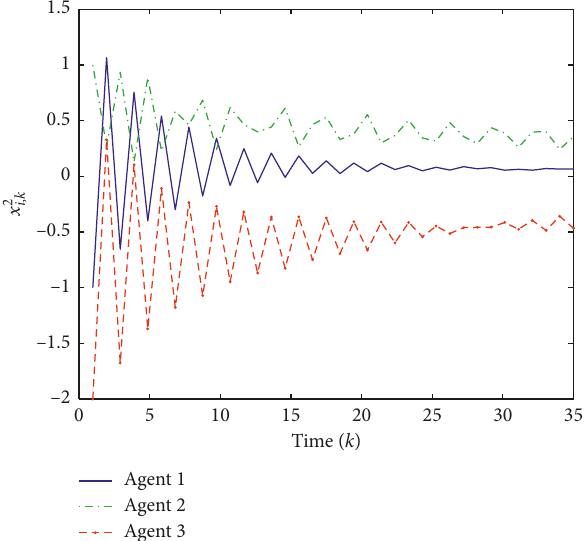
Figure 2: The state trajectories of x 2 controller.